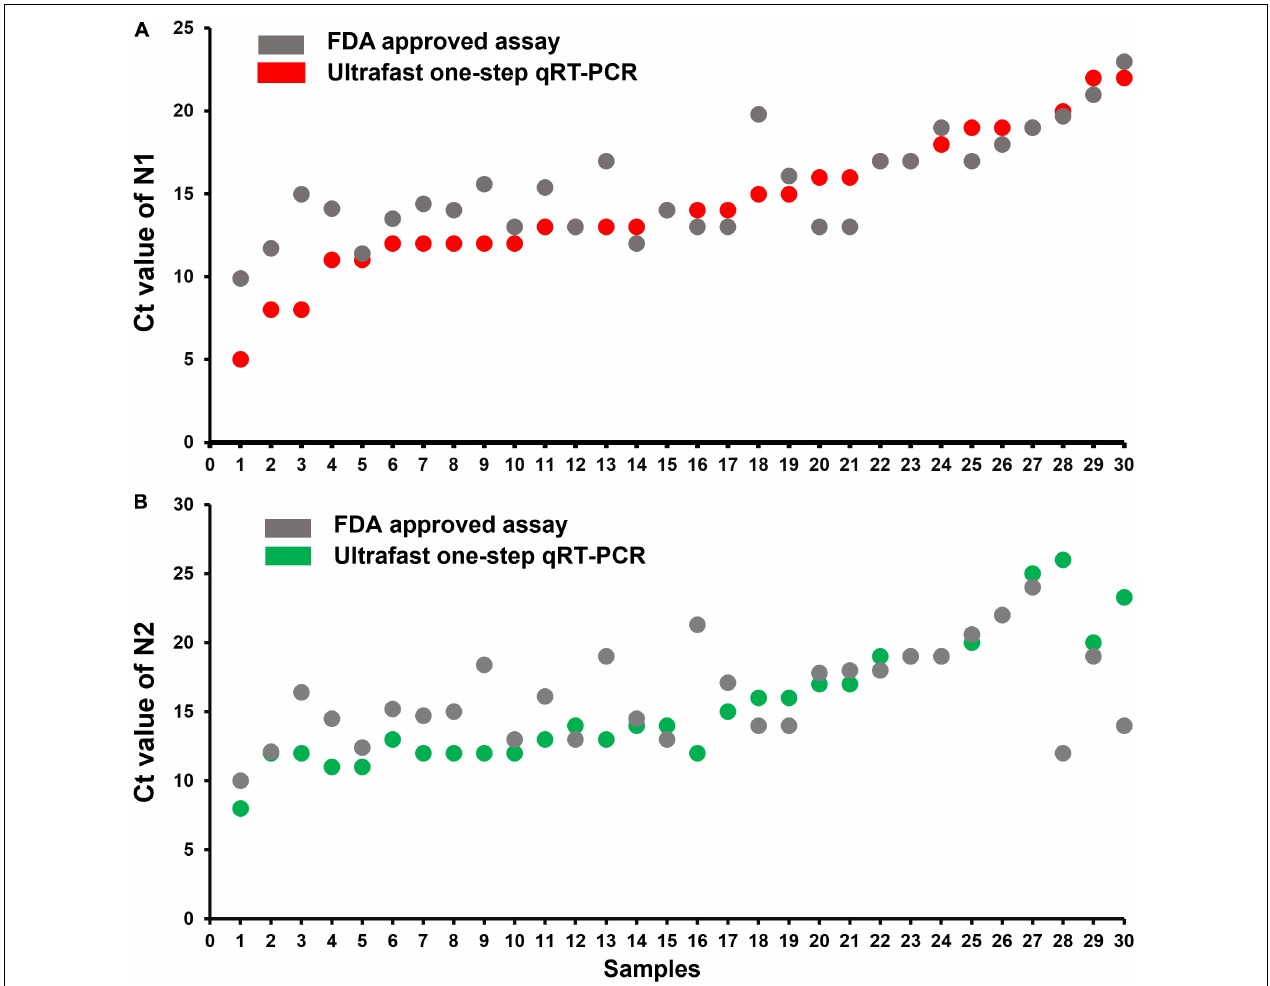
FIGURE 3 | Cycle threshold (Ct values) of N1 and N2 correlation of ultrafast one-step qRT-PCR with FDA-approved assay “Xpert R (cid:13) Xpress SARS-CoV-2” for SARS-CoV-2 positive samples. (A) Ct value of N1 and (B) Ct value of N2 from the 30 SARS-CoV-2 positive